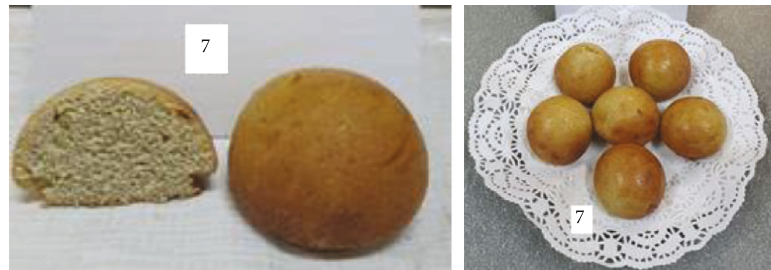
Figure 8: Sample no. 7 made from 15% mung fl our and 50 g of sugar beet powder.